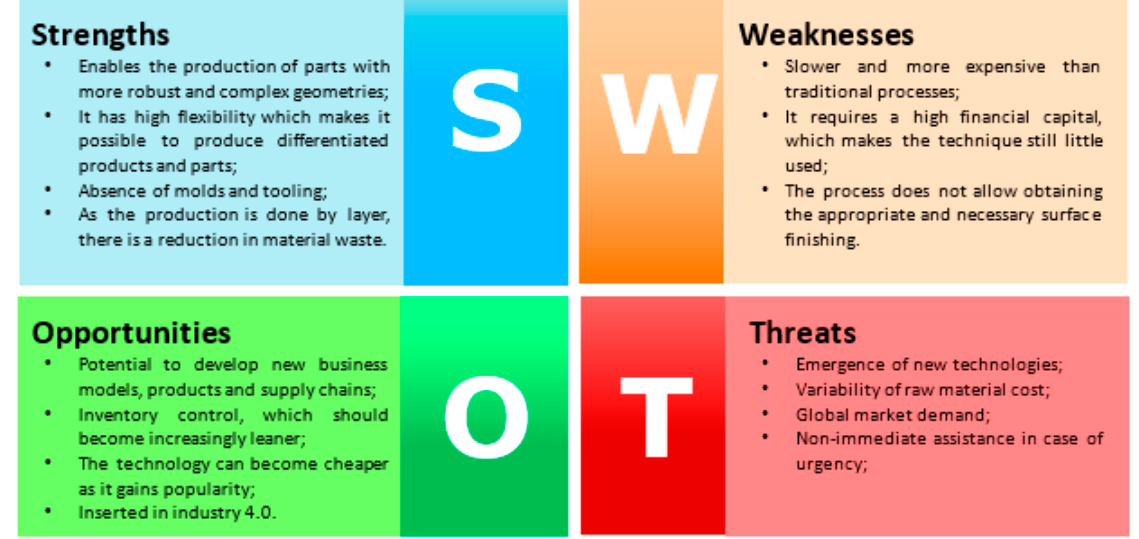
Figure 5. SWOT analysis regarding additive manufacturing.